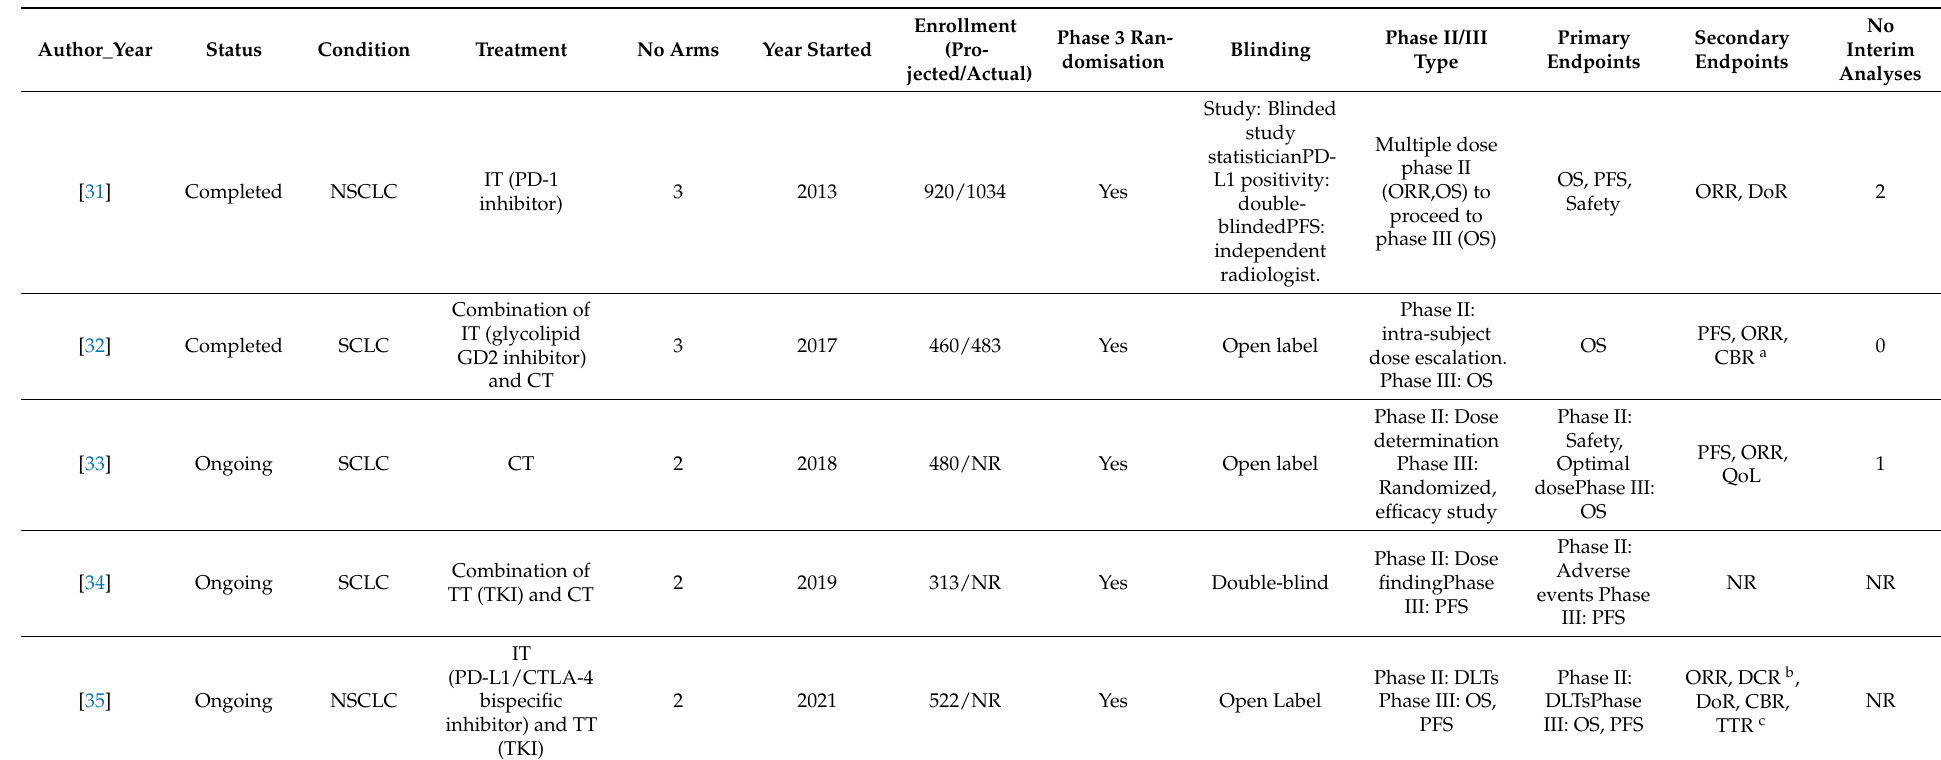
Table 3. Dose escalation Phase II/III